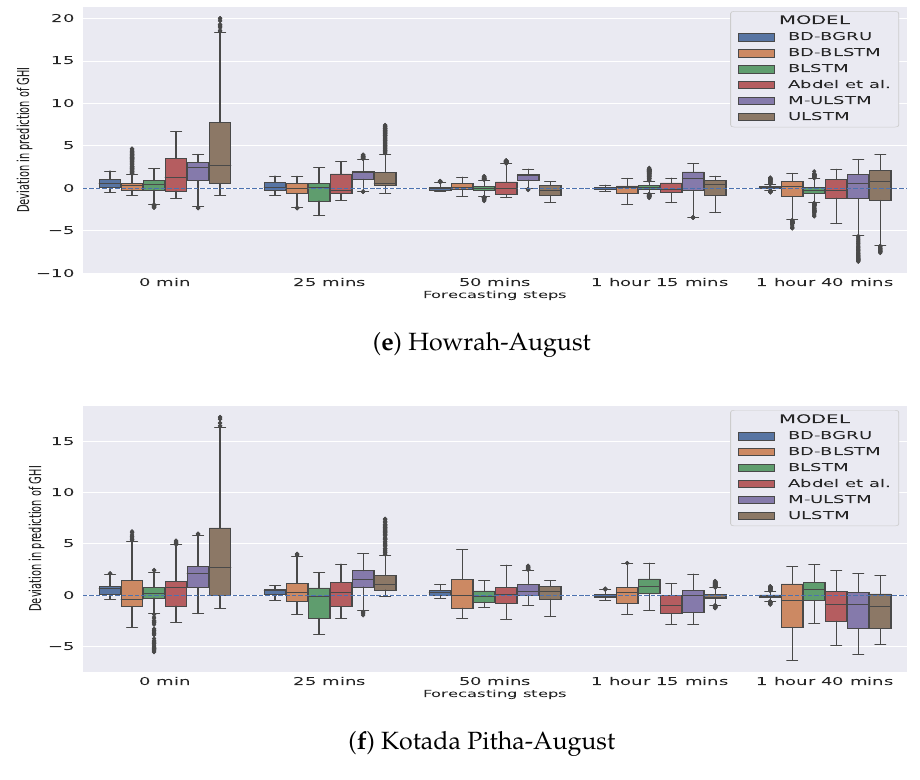
Figure 6. Variability in deviation of GHI (W/m 2 ) in the rainy season.